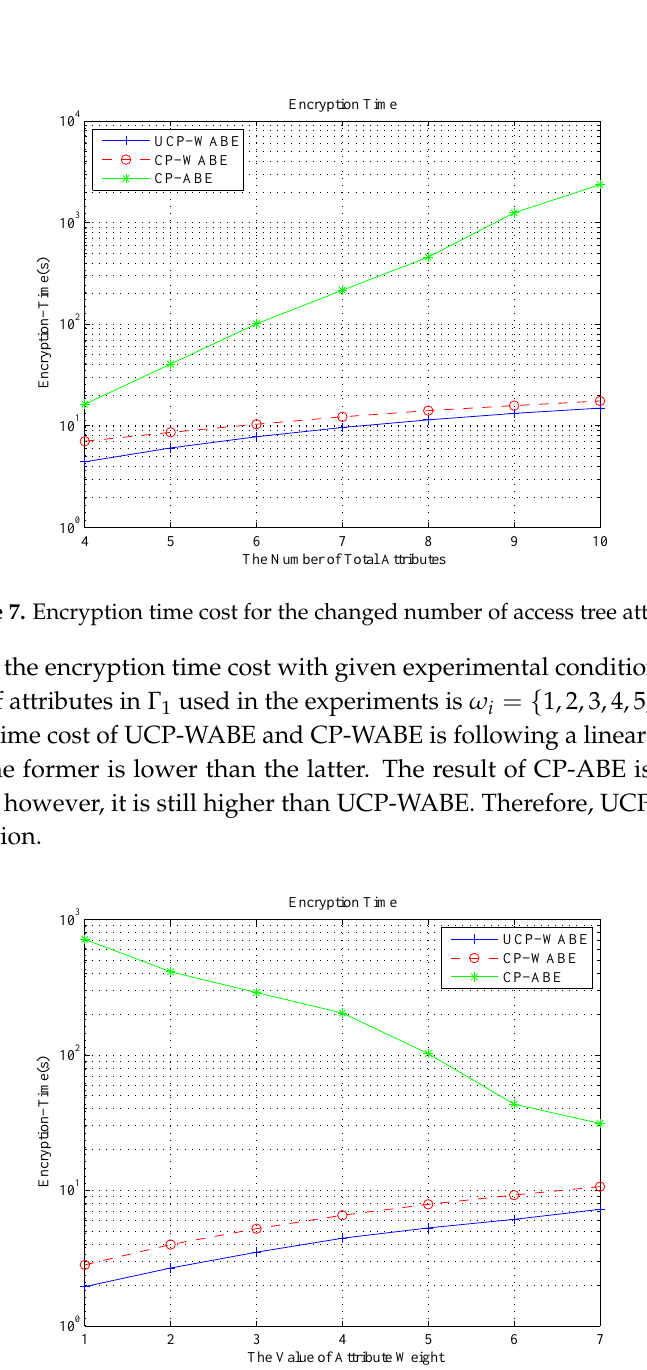
Figure 8. Encryption time cost for the changed weight of attributes in the access